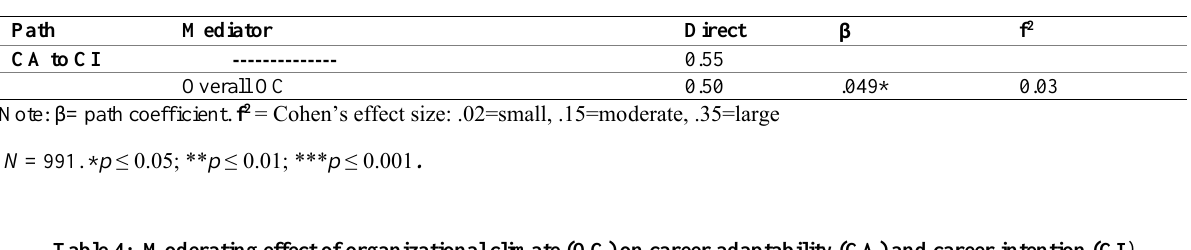
Table 4: Moderating effect of organizational climate (OC) on career adaptability (CA) and career intention (CI ) Path Moderator Direct β f 2 CA to CI -------------- 0.55 Overall OC 0.50 -0.01